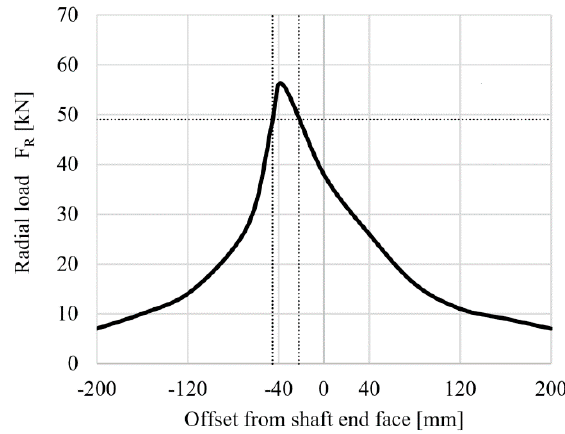
Figure 3. Permitted radial load of hydraulic motor drive shaft. (Dotted lines refer to the permitted radial load and offset range for maximum vehicle mass).